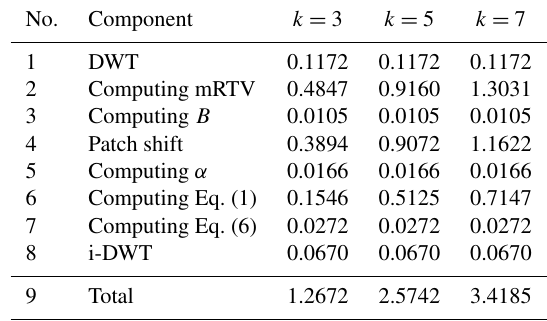
Table 1. Time consumption of each component of the algorithm in this paper